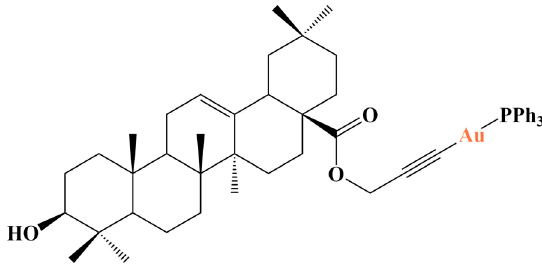
Figure 33. One of the complexes presented in [117].